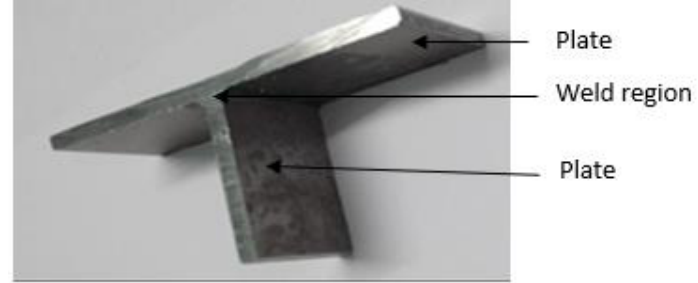
Figure 2. T-joint welding operation using a friction stir welding process.